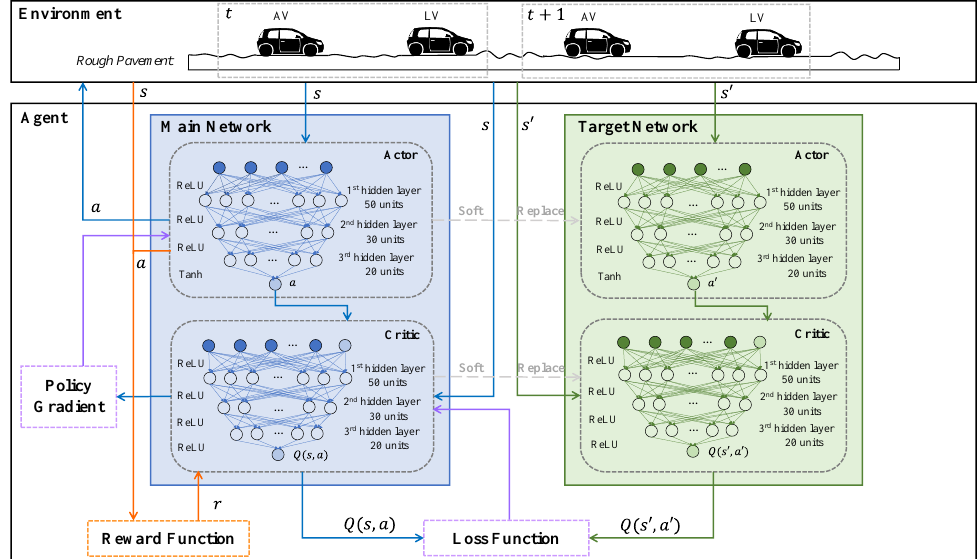
Figure 4. Structure of the DDPG model.